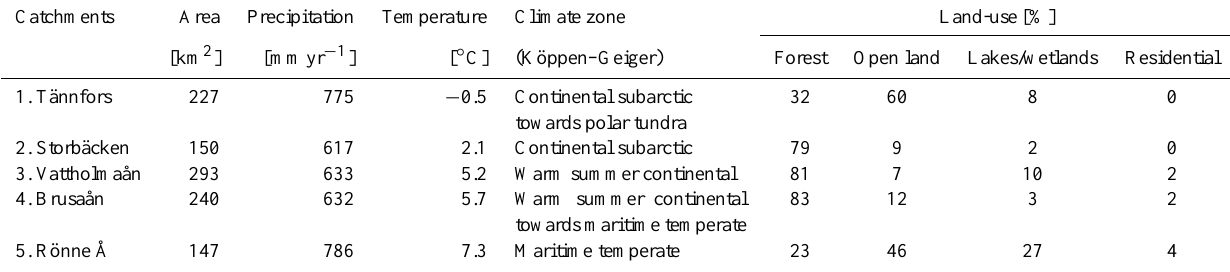
Table 2. Main characteristics of the five Swedish study sites including area, total annual precipitation, mean annual temperature, climate zones and land-use